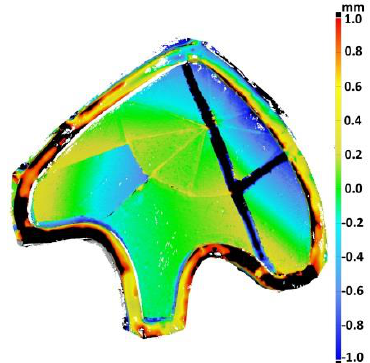
Figure 8. 3D inspection of nIII , Koszewko, showing the restoration of strongly fragmented glass 4.2.2 Legnica: The surface comparison of the inside of the